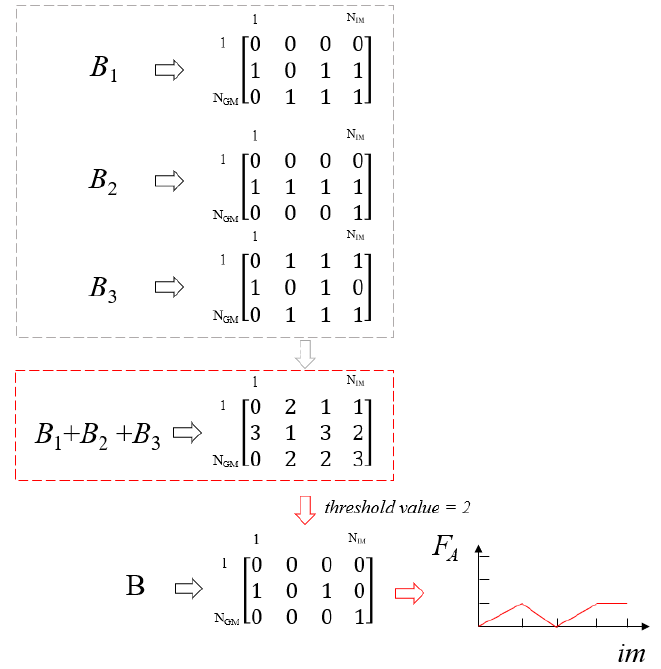
Figure 4. Flowchart for the damage extent fragility functions estimation.